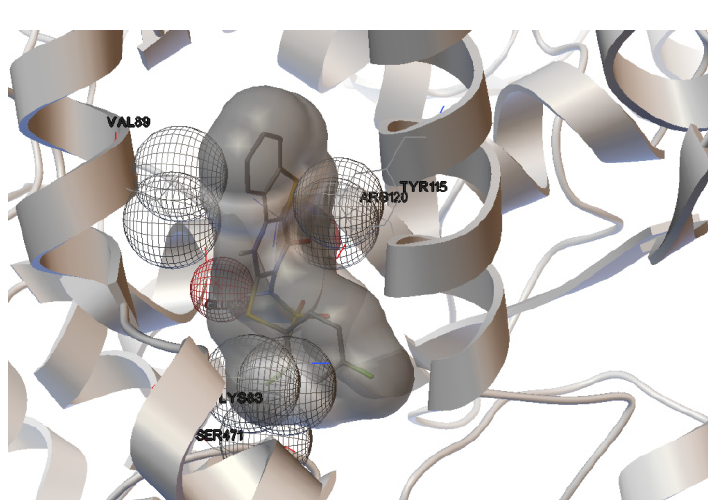
Figure 5. Binding of 8 into the active site of COX–2.